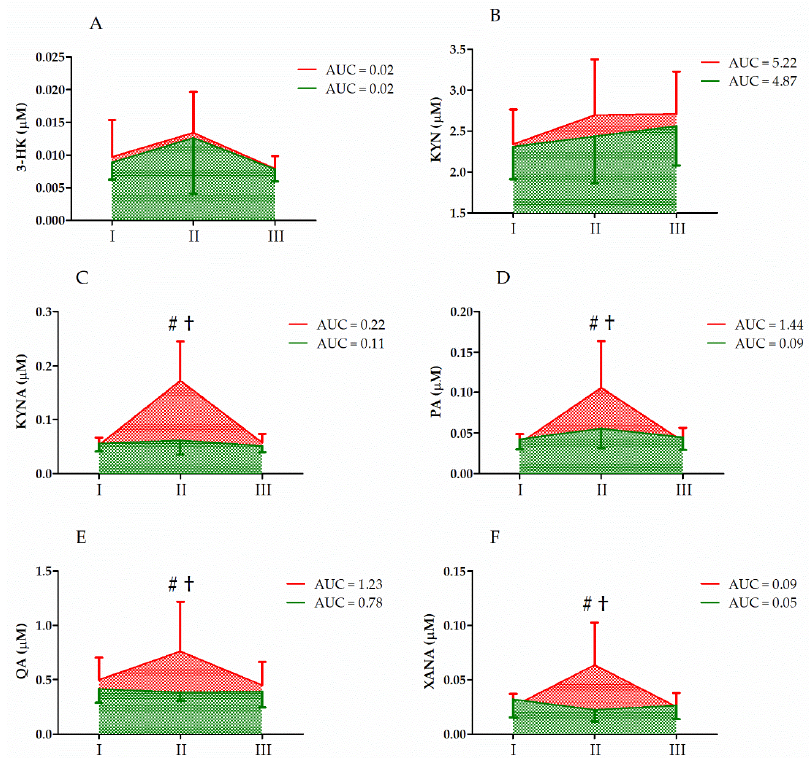
Figure 1. Changes in serum KYN metabolite levels after the ultramarathon in runners who received a single high dose of vitamin D (supplemented group, green) and runners who received the placebo (control group, red). Sampling: I, 24 h before the run; II, immediately after the run; and III, 24 h after the run. ( A ) 3-HK, 3-hydroxy- L -kynurenine; ( B ) KYN, kynurenine; ( C ) KYNA, kynurenic acid; ( D ) PA, picolinic acid; ( E ) QA, quinolinic acid; ( F ) XANA, xanthurenic acid. †, Significant difference vs. 24 h before and 24 after the run; #, significant difference vs. supplemented group immediately after the run. The significance threshold was set at p < 0.01.